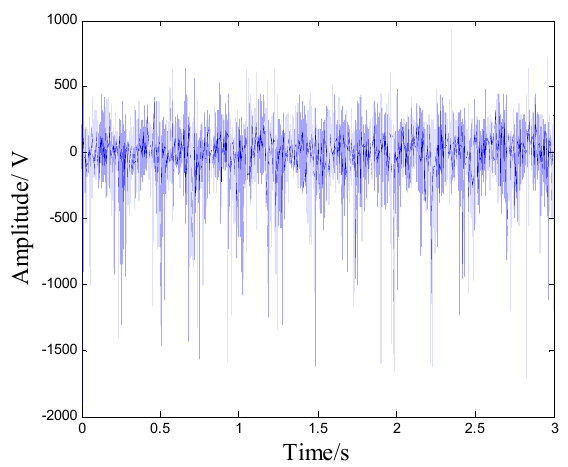
Figure 32. The time domain plot of wearing gear.